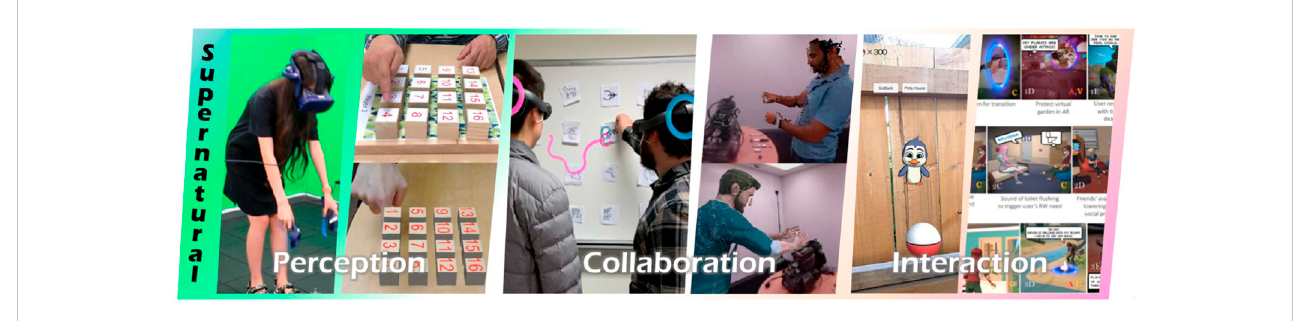
Six original research articles under three themes of supernatural perception for enhanced empathy, supernatural communication for enhanced collaboration, and supernatural interaction across reality ‒ virtuality have been compiled in this study (Zhang et al., Li et al., Jing et al., Sasikumar et al., Dong et al., and Piumsomboon et